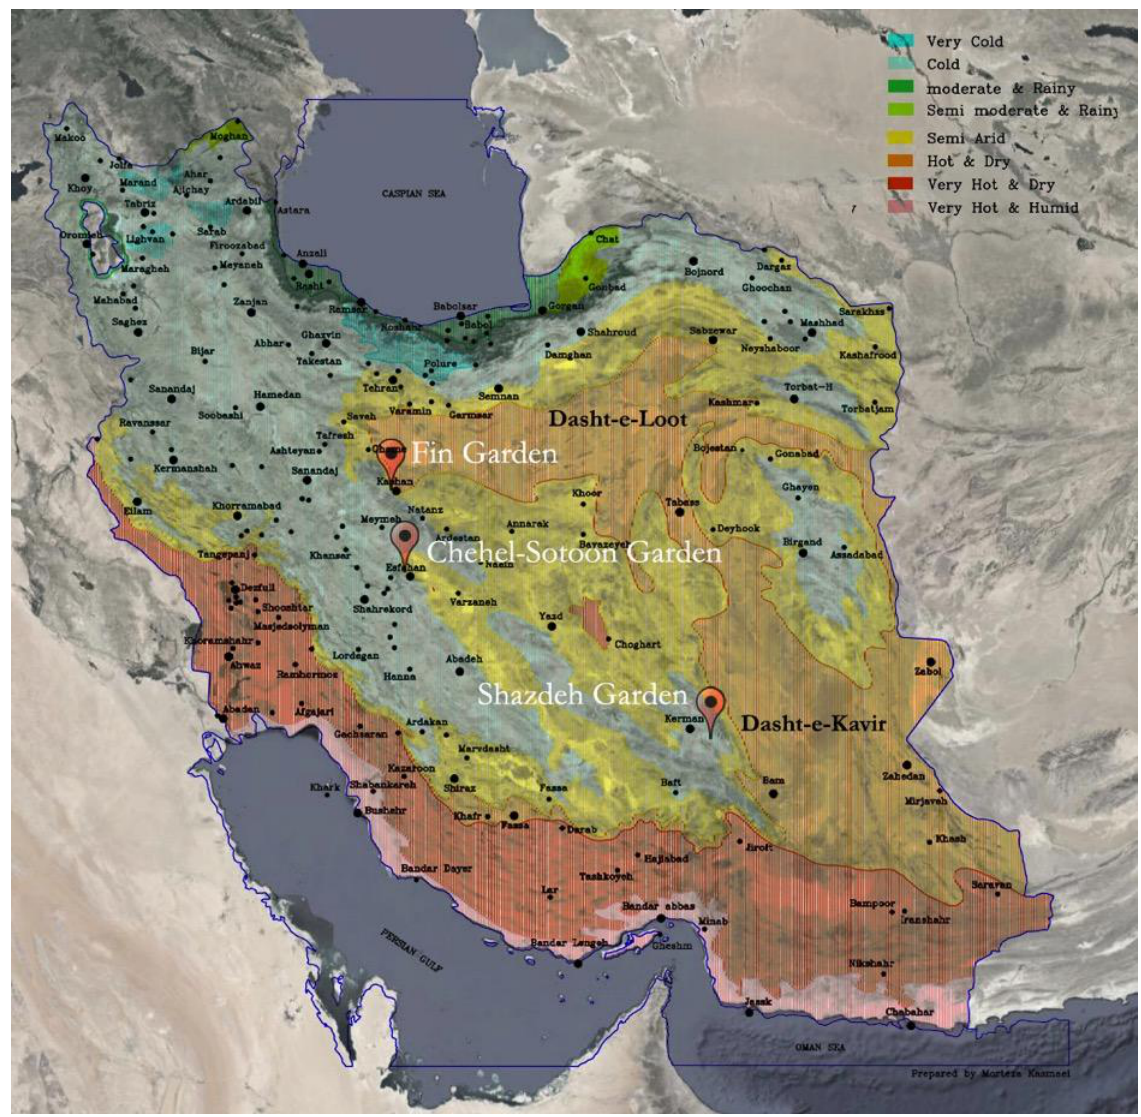
Figure 1. Placement of the three selected gardens in Iran, close to the central deserts. ( Source: own work